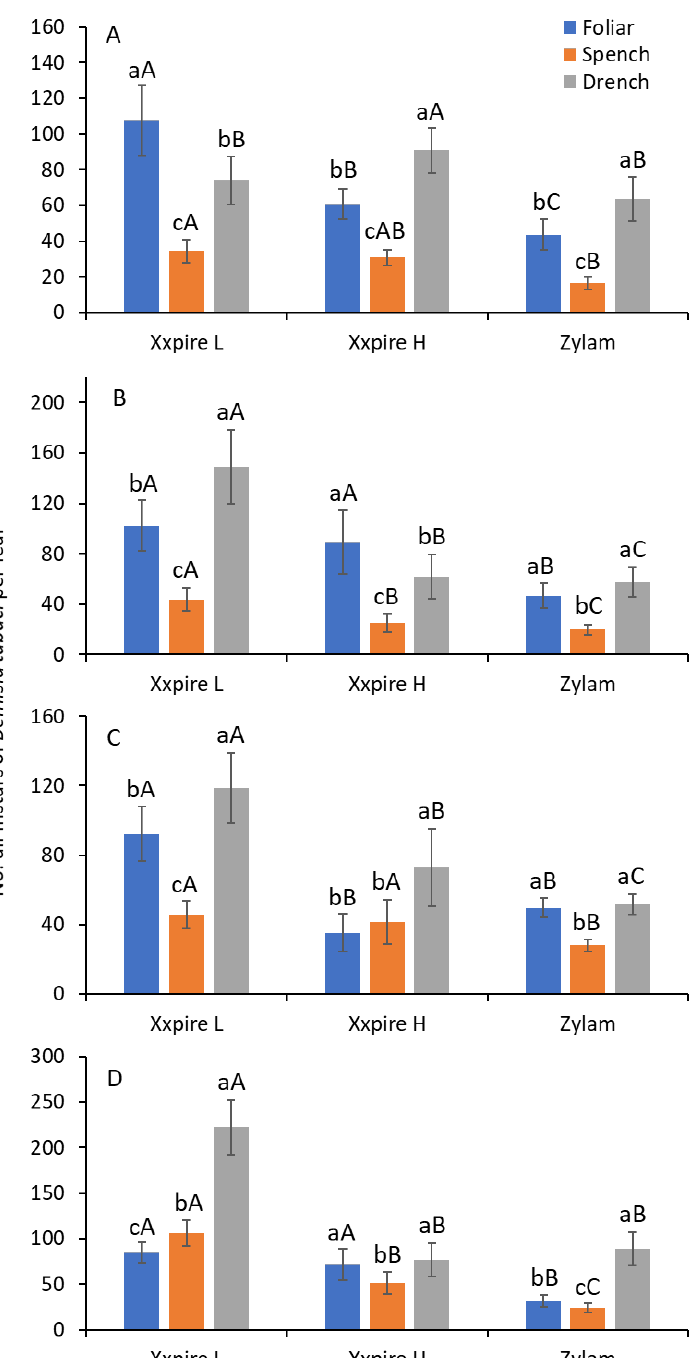
Figure 3. Combined instars. Least-squares mean (±SE) numbers of all instars of B. tabaci observed on poinsettia leaves treated with various insecticides and application methods in the greenhouse at ( A ) 7, ( B ) 14, ( C ) 21, and ( D ) 28 days after application. Same lower-case letters among methods within insecticide treatment are not significantly different at α = 0.05 (Tukey–Kramer test), and same upper-case letters among same-colored bars (application method) are not significantly different at α = 0.05 (Tukey–Kramer